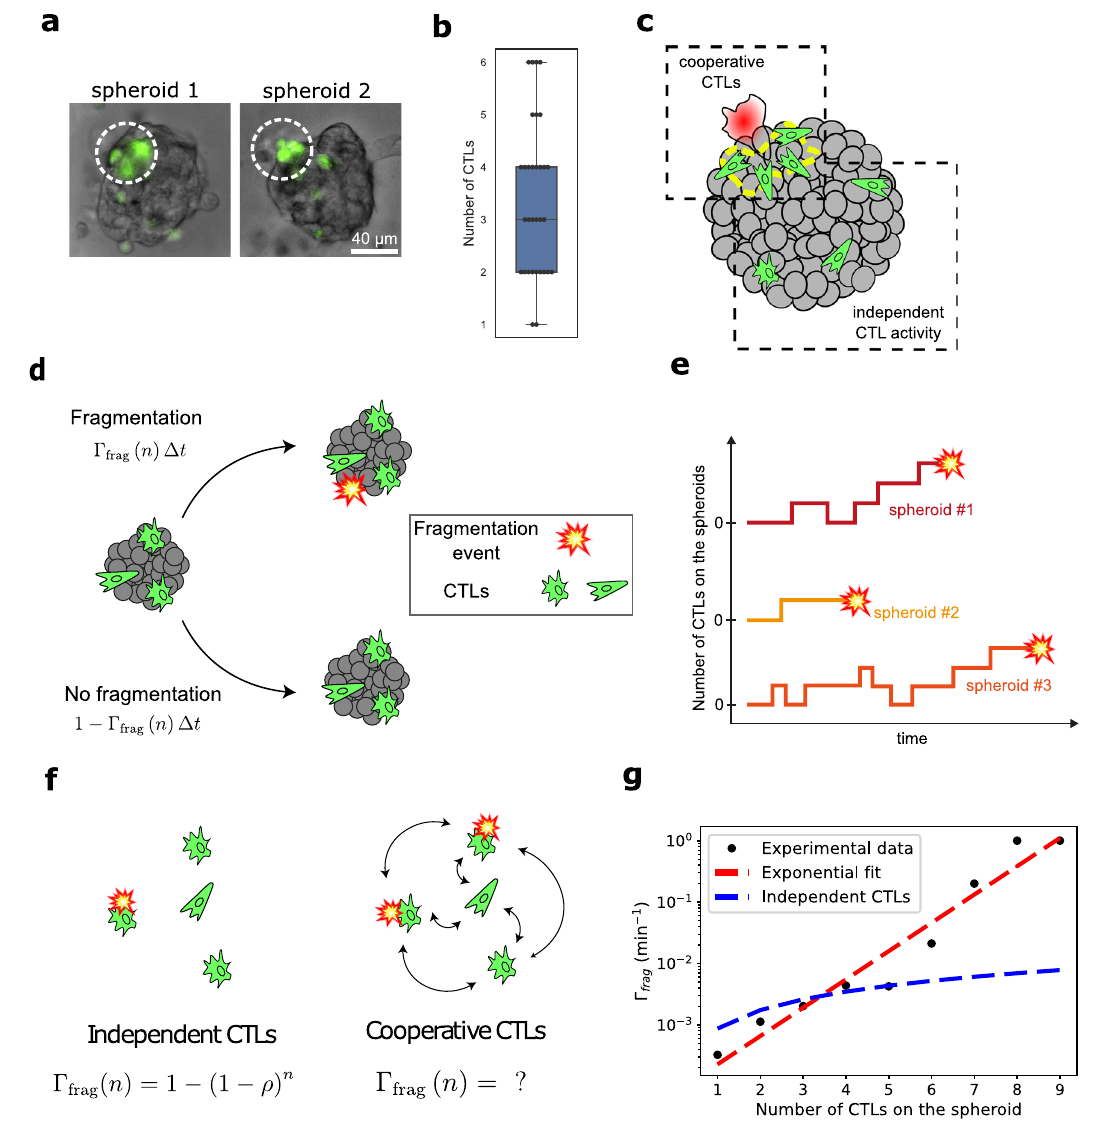
Fig. 5 CTL number and collective behavior determine probability of killing. a Two representative images showing CTL clustering on the spheroid during fi rst fragmentation event. The white circles have a radius of 30 μ m around fragmenting cell. b Distribution of the CTL numbers within a radius ≤ 30 μ m around the fragmentation areas ( N = 31). c Sketch summarizing the observed trends: CTLs (green) migrate on the surface of the spheroid and cluster together in particular regions, where fragmentation of B16 cells (red) is observed. d During a time-interval Δ t , a spheroid with n CTLs attached to it has a probability Γ frag Δ t of fragmenting. e Illustration of possible scenarios of the number of CTLs on the spheroids and the apparition of fragmentation. f The fragmentation rate Γ frag can be modeled as the result of independent CTLs interacting with the spheroid, with an individual fragmentation rate per CTL worth ρ . Conversely, the fragmentation rate can be viewed as the result of a collaborative process. g Estimates of Γ frag as a function of the number of CTLs on the spheroid n . Experimental measurements ( N = 84, black dots) are fi tted with an exponential (dashed red line) compared with the results of the independent CTL model (dashed blue line). Source data are provided as a Source data fi